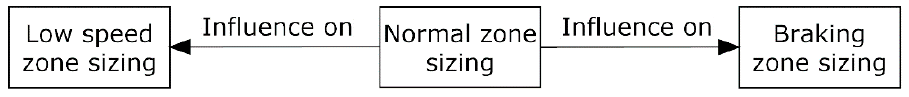
Figure 4. Zone sizing influences.